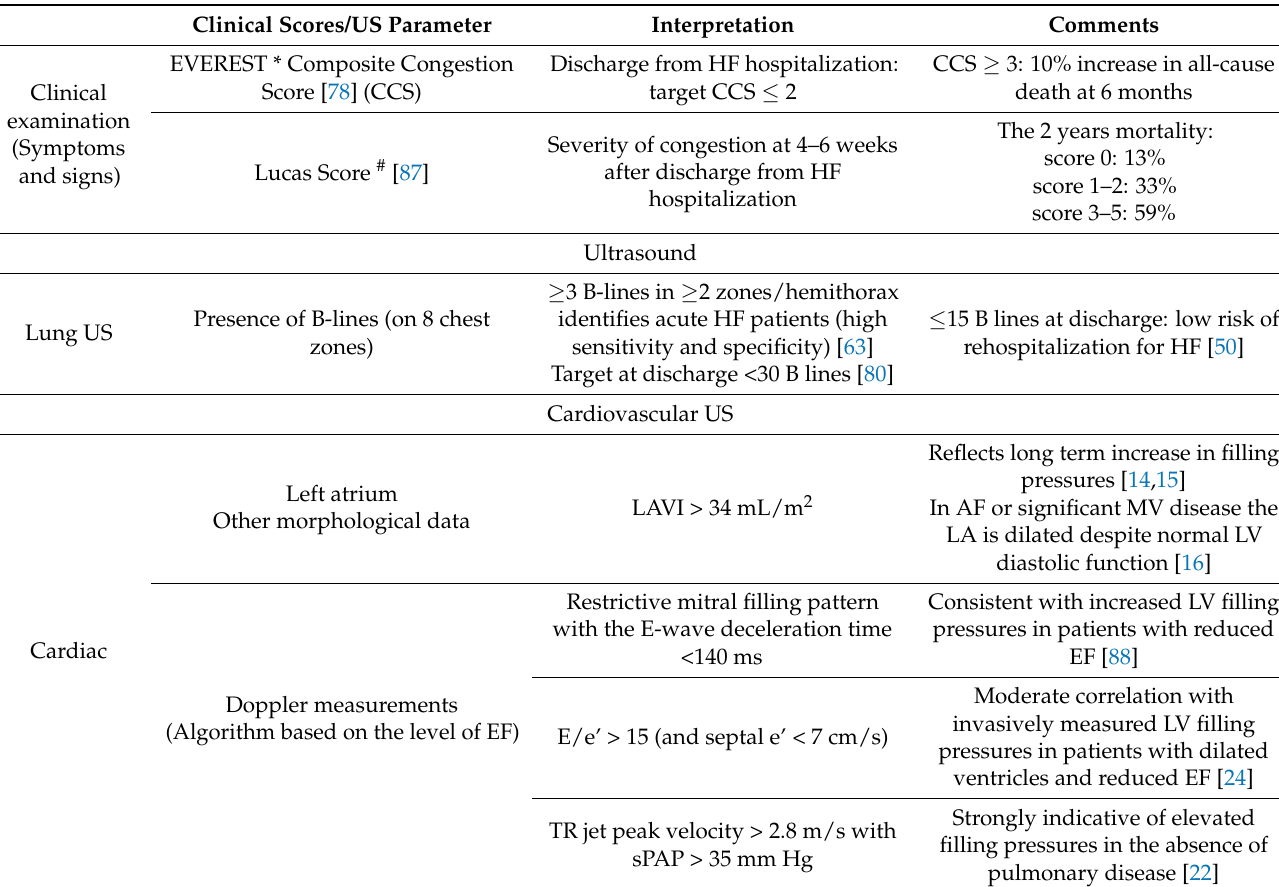
Table 1. Clinical and ultrasound parameters of congestion in heart